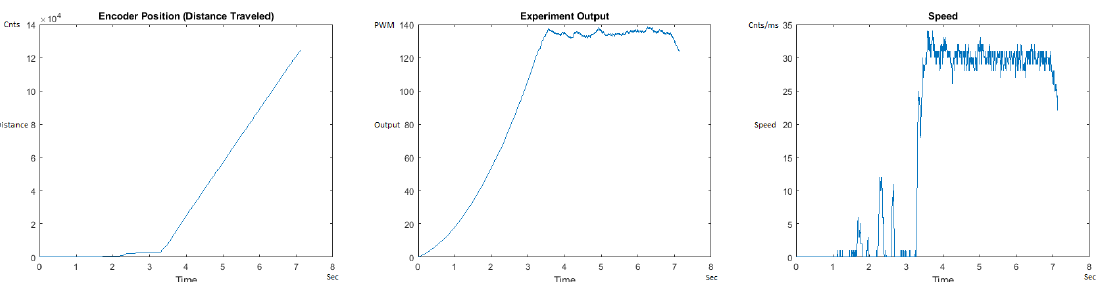
Figure 19. Encoder position, output and speed plots for PID++ UP operation— Vmax 30 cnts/ms, Adesired 0.040 cnts/ms 2 — 10 g.